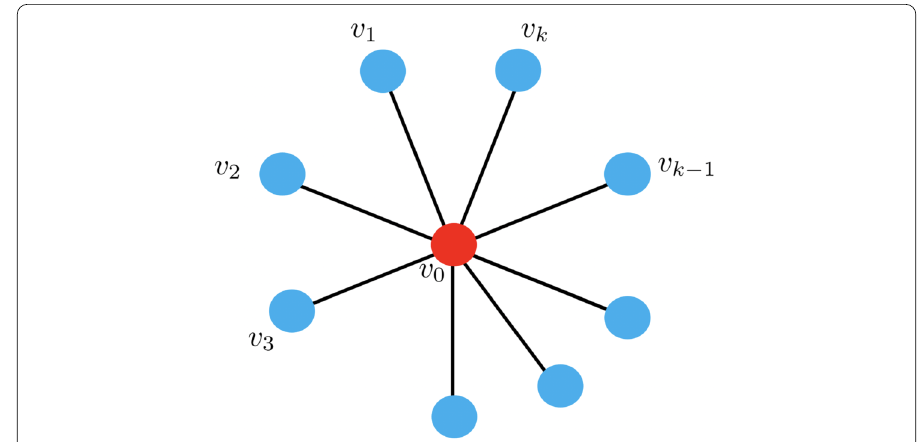
Figure 1 A picture of a star graph G (cid:2) having k edges and a junction node v